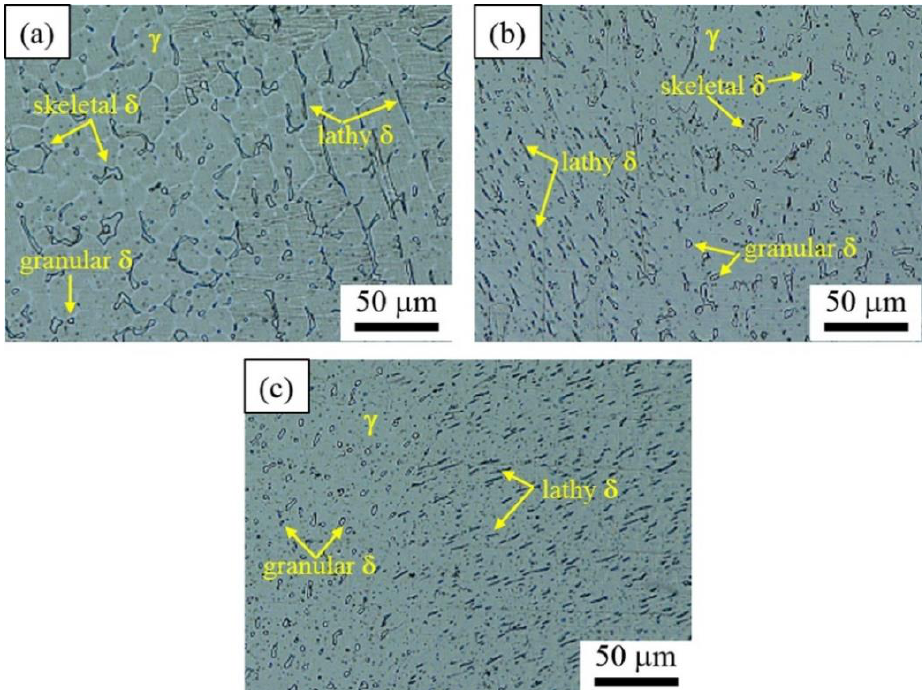
Figure 5. Microstructure of WAAM 308 L stainless steel characterized by optical microscopy at ( a ) top layer, ( b ) middle layer, and ( c ) bottom layer. Reprinted with permission from [25], Copyright 2021 Elsevier.